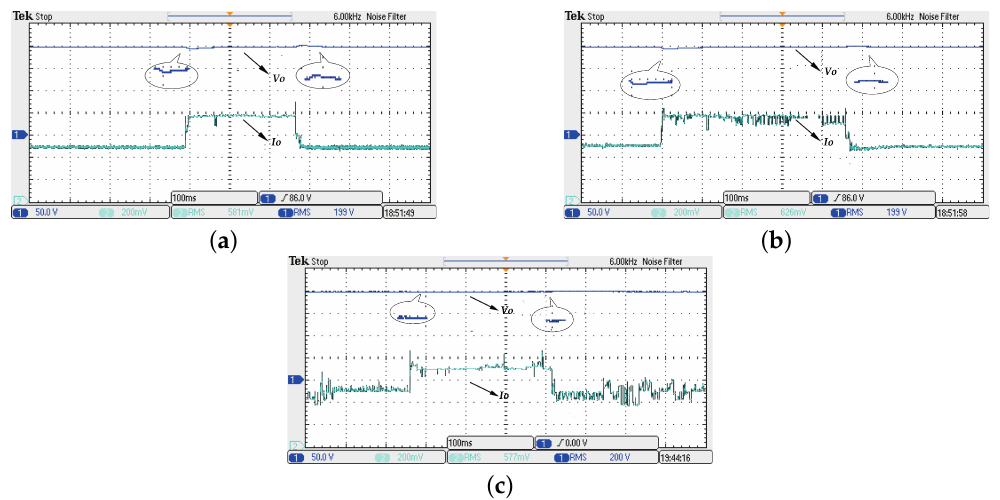
Figure 10. The response of the system against load disturbance: ( a ) Controlled by the TSM controller ( S 1 ); ( b ) controlled by the FTSM controller ( S 2 ); ( c ) controlled by the proposed NFTSM controller ( S 3